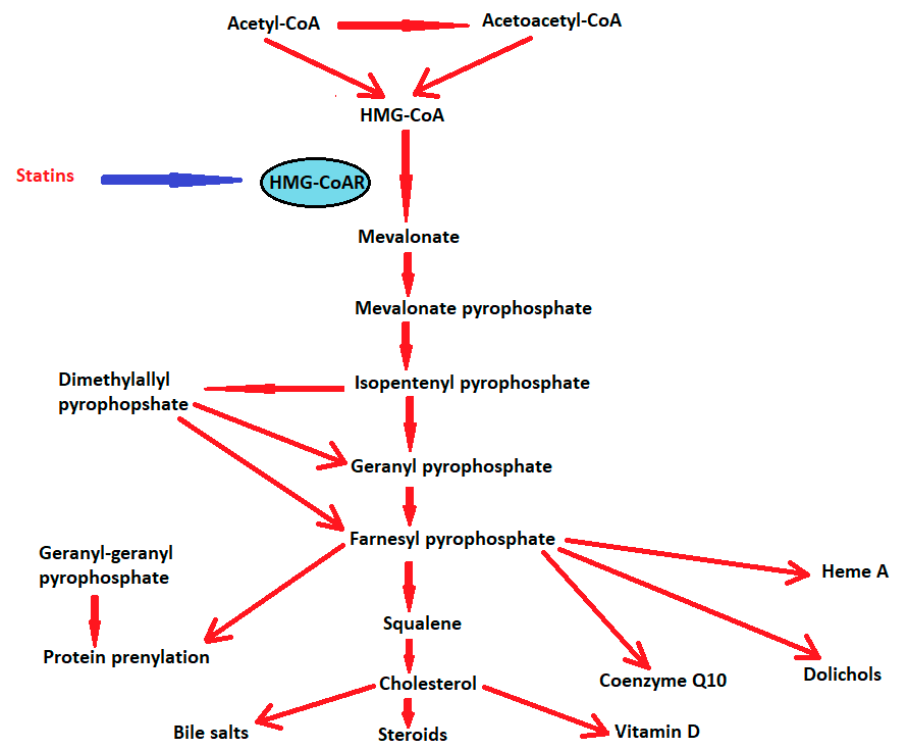
Figure 2. The mevalonate pathway. Statins act by inhibiting hydroxy-3-methylglutaryl-Coenzyme A reductase (HMG-CoAR), as depicted with the blue arrow.